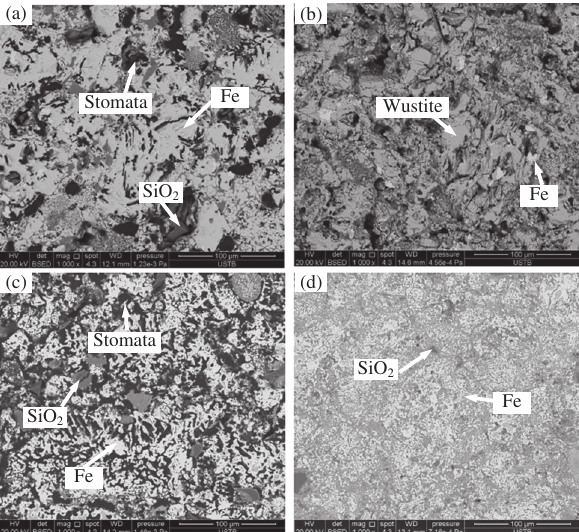
Figure 3: Microstructure of pre-reduced pellet in general condition [(a) edge; (b) center] and high reduction potential condition [(c) edge; (d) center].